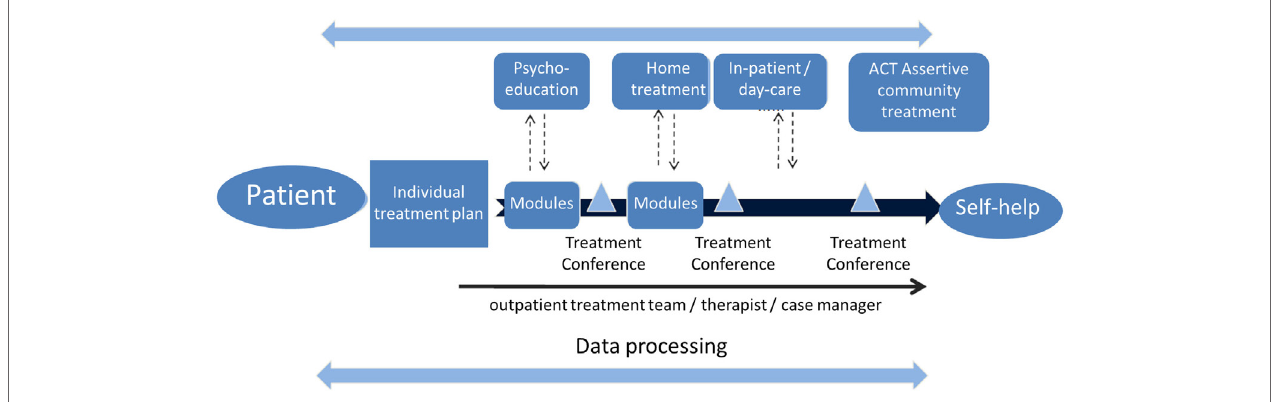
FigUre 1 | Patient-centered approach in the integrated care initiative schizophrenia